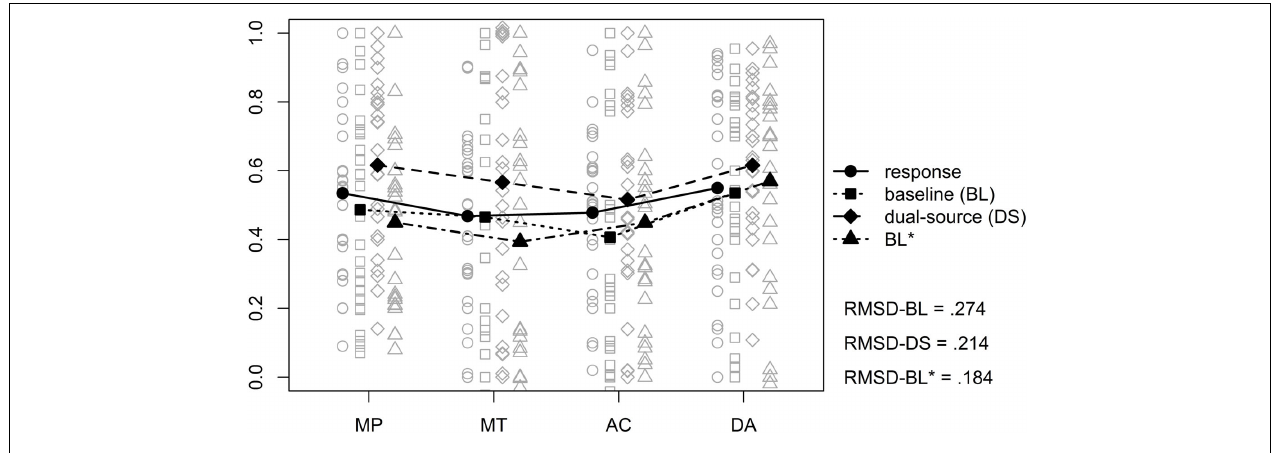
FIGURE 5 | Mean (filled symbols) and individual (non–filled symbols) model predictions and observed responses from the probabilized conditional inference task. The solid line shows the observed responses and the different dashed lines show the different models. A small amount of